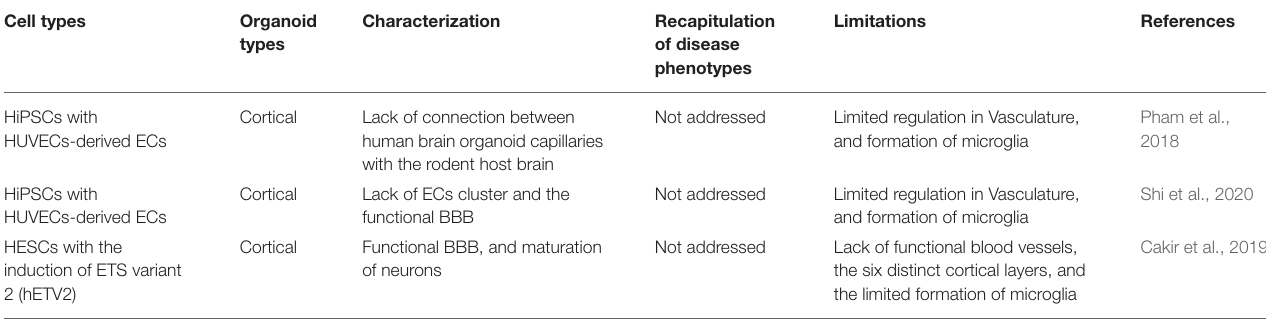
TABLE 3 | Current protocols for hiPSC-derived 3D vascularized